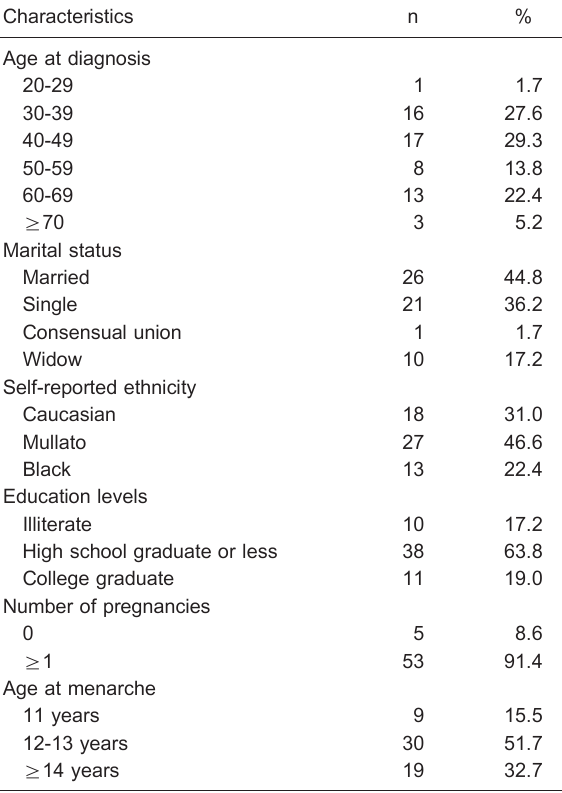
Table 1. General characteristics of the 58 women included in the study.